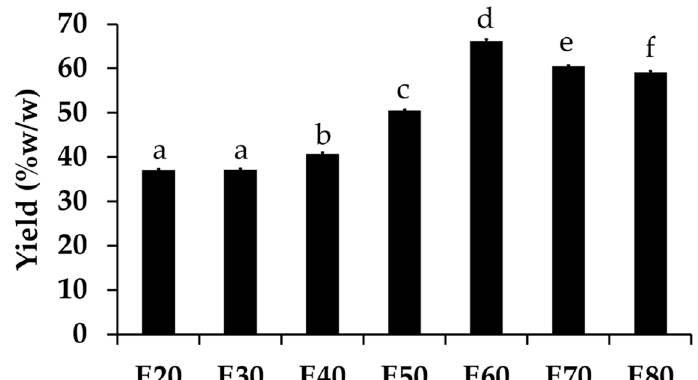
Figure 1. Yield of Sripanya pomegranate peel extracts. E20, E30, E40, E50, E60, E70, and E80 were Sripanya pomegranate peel extracts obtained by maceration in 20%, 30%, 40%, 50%, 60%, 70%, and 80% v/v of ethanol, respectively. Different letters denote statistically significant differences among groups; p < 0.05).